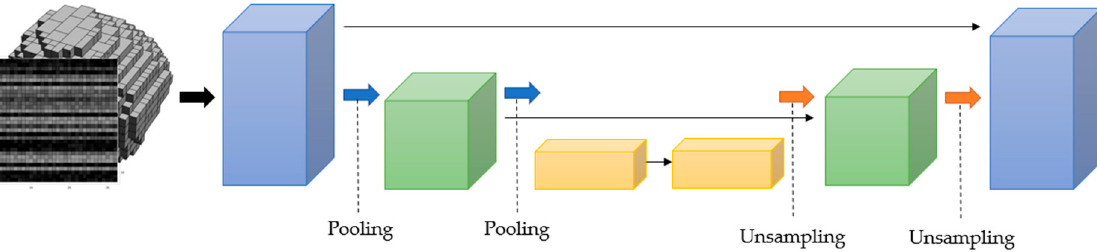
Figure 3. U-Net Architecture.